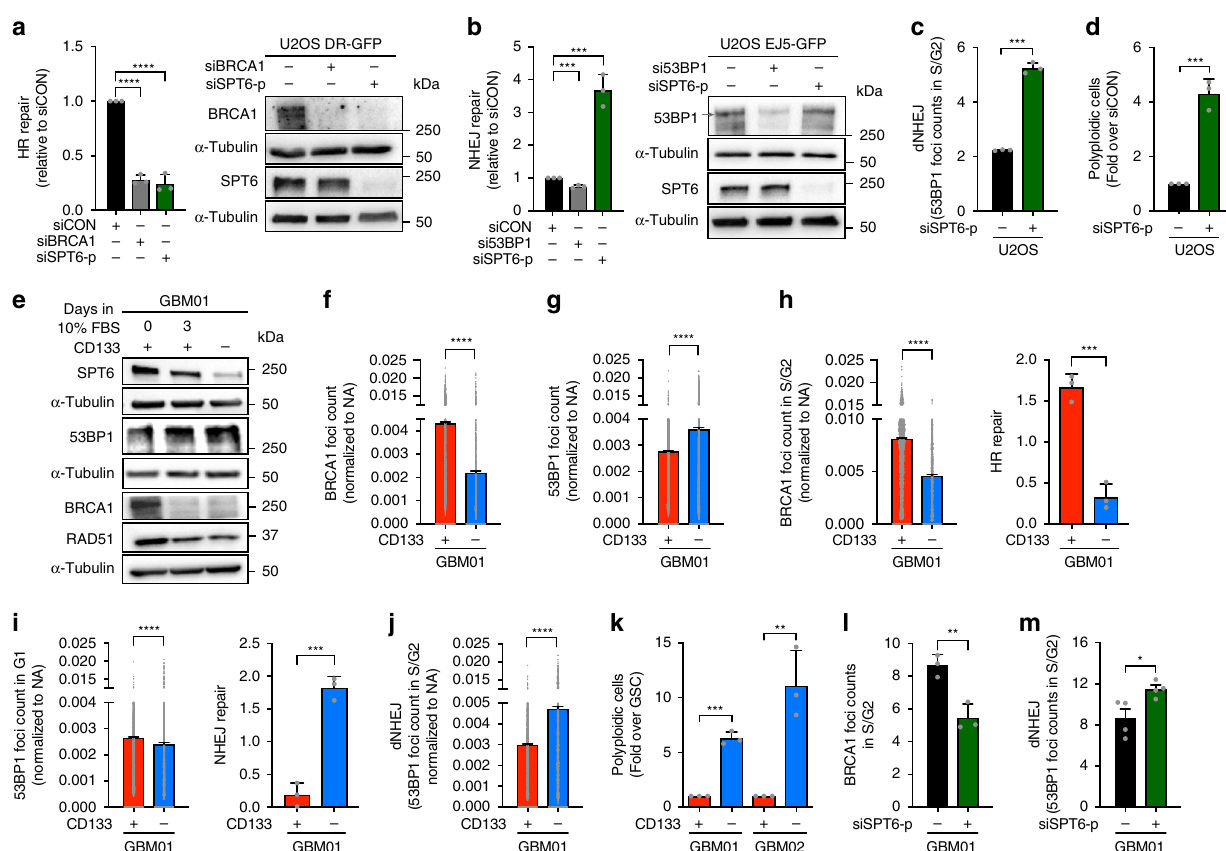
Fig. 5 SPT6 levels dictate DSBs repair pathway choice. a Left: HR repair in DR-GFP cells transfected with siCON, siSPT6-p or siBRCA1. Data presented as mean ± s.d. **** p < 0.0001. Right: Representative immunoblot of BRCA1 and SPT6 levels in DR-GFP cells transfected with siCON, siSPT6-p or siBRCA1. b Left: NHEJ repair in EJ5-GFP cells transfected with siCON, siSPT6-p or si53BP1. Data presented as mean ± s.d. *** p = 0.0005 and *** p = 0.0007. Right: Representative immunoblot of 53BP1 and SPT6 levels in EJ5-GFP cells transfected with siCON, siSPT6-p, si53BP1. c dNHEJ in U2OS cells transfected with siCON or siSPT6-p. Data are presented as mean ± s.d. **** p < 0.0001. d FACS analysis of polyploid cells after SPT6 silencing in U2OS. Data normalized to siCON and presented as mean ± s.d. *** p = 0.0004. e Representative immunoblot analysis of SPT6, 53BP1, BRCA1 and RAD51 expression in GSCs, differentiated GSCs and DGCs. f BRCA1 foci quanti fi cation in matched GSCs (n = 8505) and DGCs ( n = 2690). **** p < 0.0001. ( g ) 53BP1 foci quanti fi cation in matched GSCs ( n = 9704) and DGCs ( n = 5817). **** p < 0.0001. h Left: BRCA1 foci quanti fi cation in S/G2 phase GSCs ( n = 3511) and DGCs ( n = 1011). **** p < 0.0001. Right: HR repair in matched GSCs and DGCs. Data are presented as mean ± s.d. *** p = 0.0005. i Left: 53BP1 foci quanti fi cation in G1 phase GSCs ( n = 5403) and DGCs ( n = 2473). **** p < 0.0001. Right: NHEJ repair in matched GSCs and DGCs. Data are presented as mean ± s.d. *** p = 0.0003. j dNHEJ in matched GSCs ( n = 3451) and DGCs ( n = 1802). **** p < 0.0001. k FACS analysis of polyploid cells in matched GSCs and DGCs. Data presented as mean ± s.d. *** p = 0.0001 and **p = 0.0054. l BRCA1 foci quanti fi cation in S/G2 phase GSCs transfected with siCON or siSPT6-p. Data are presented as mean ± s.d. ** p = 0.0068. m dNHEJ in GSCs transfected with siCON or siSPT6-p. Data are presented as mean ± s.d. * p = 0.0273. N = 3 biologically independent experiments in ( a – m ). Loading control: α -Tubulin in ( a ), ( b ), ( e ). The statistical test used in ( a – m): two-tailed unpaired t -test. Data from cells examined over three biologically independent experiments ( n = number of cells) are normalized to Nuclear Area (NA) and presented as mean ± s.e.m. in ( f ), ( g ), ( h ) Left, ( i ) Left, ( j ). Source data are provided as a Source data fi